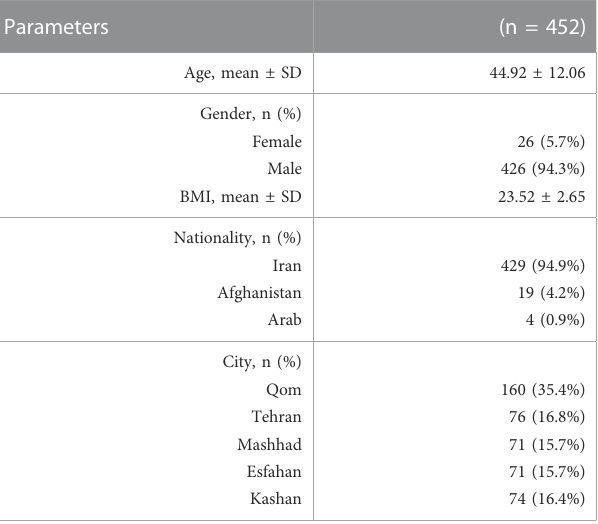
TABLE 2 Disease and medication history of patients referred to MMT centers. (n =